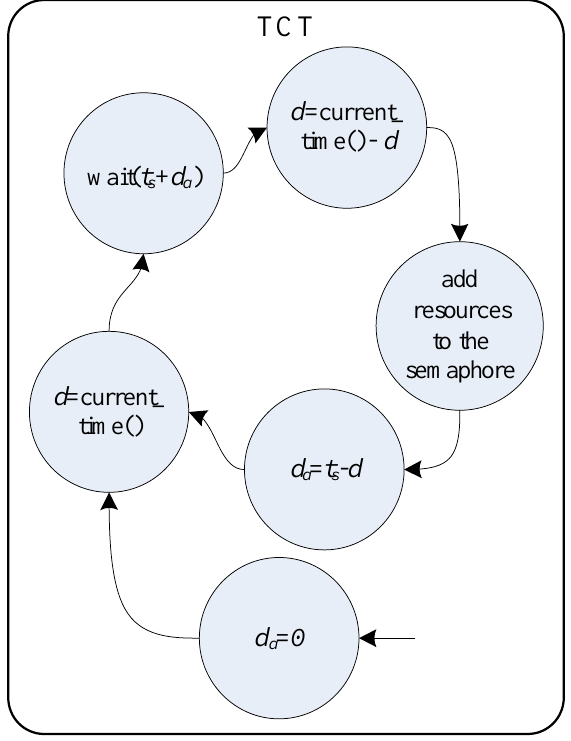
Figure 6. Finite automata associated with